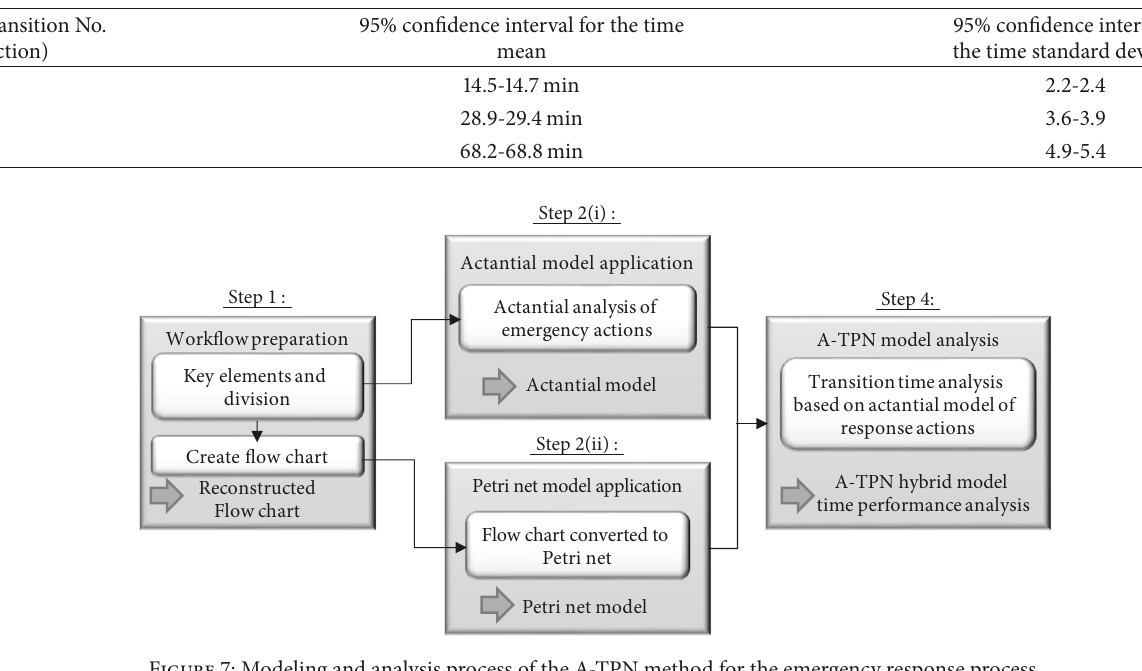
Figure 7: Modeling and analysis process of the A-TPN method for the emergency response